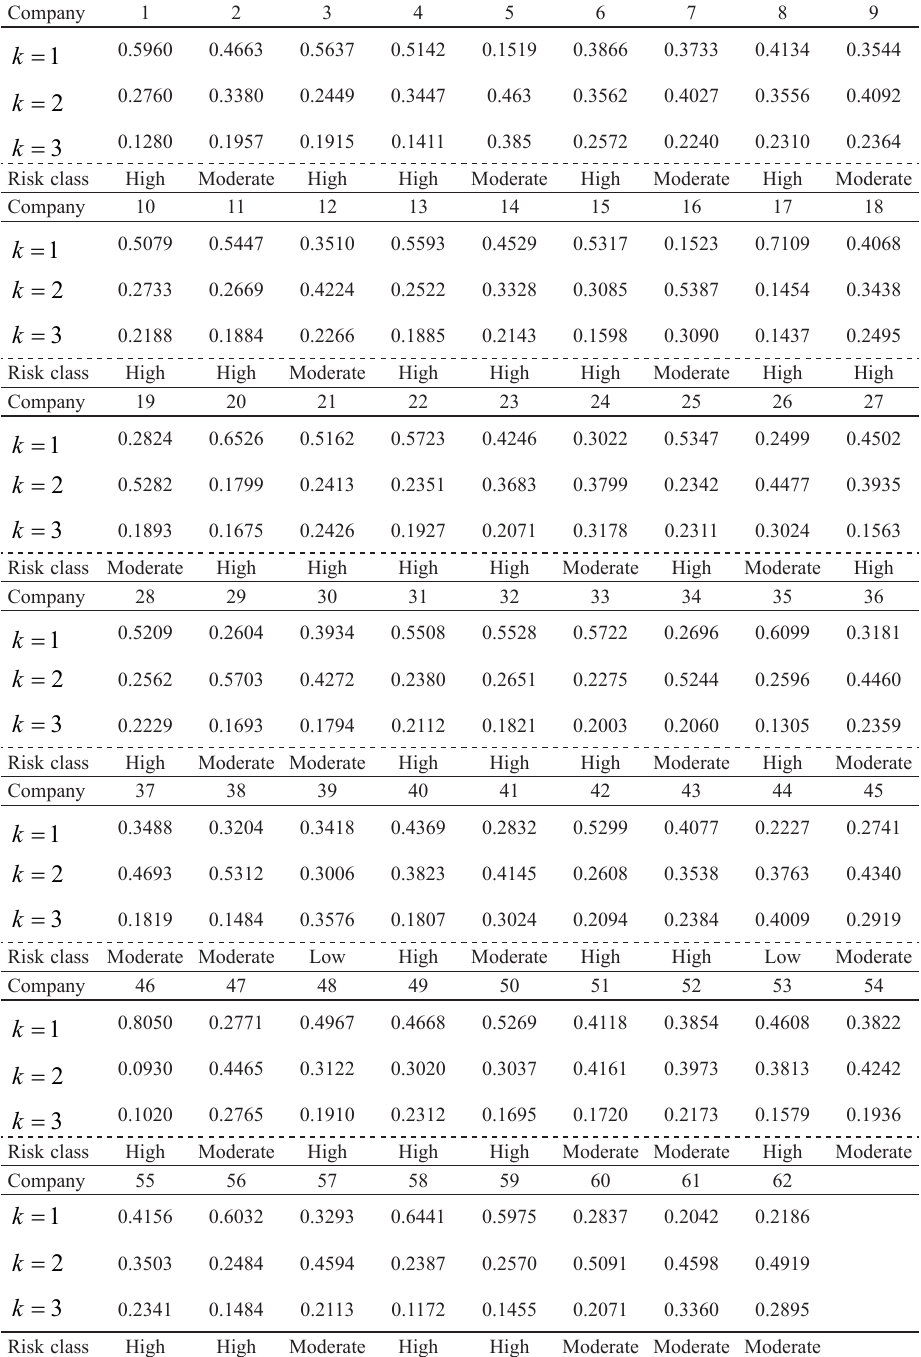
Table 4. The results of grey clustering coefficient and grey